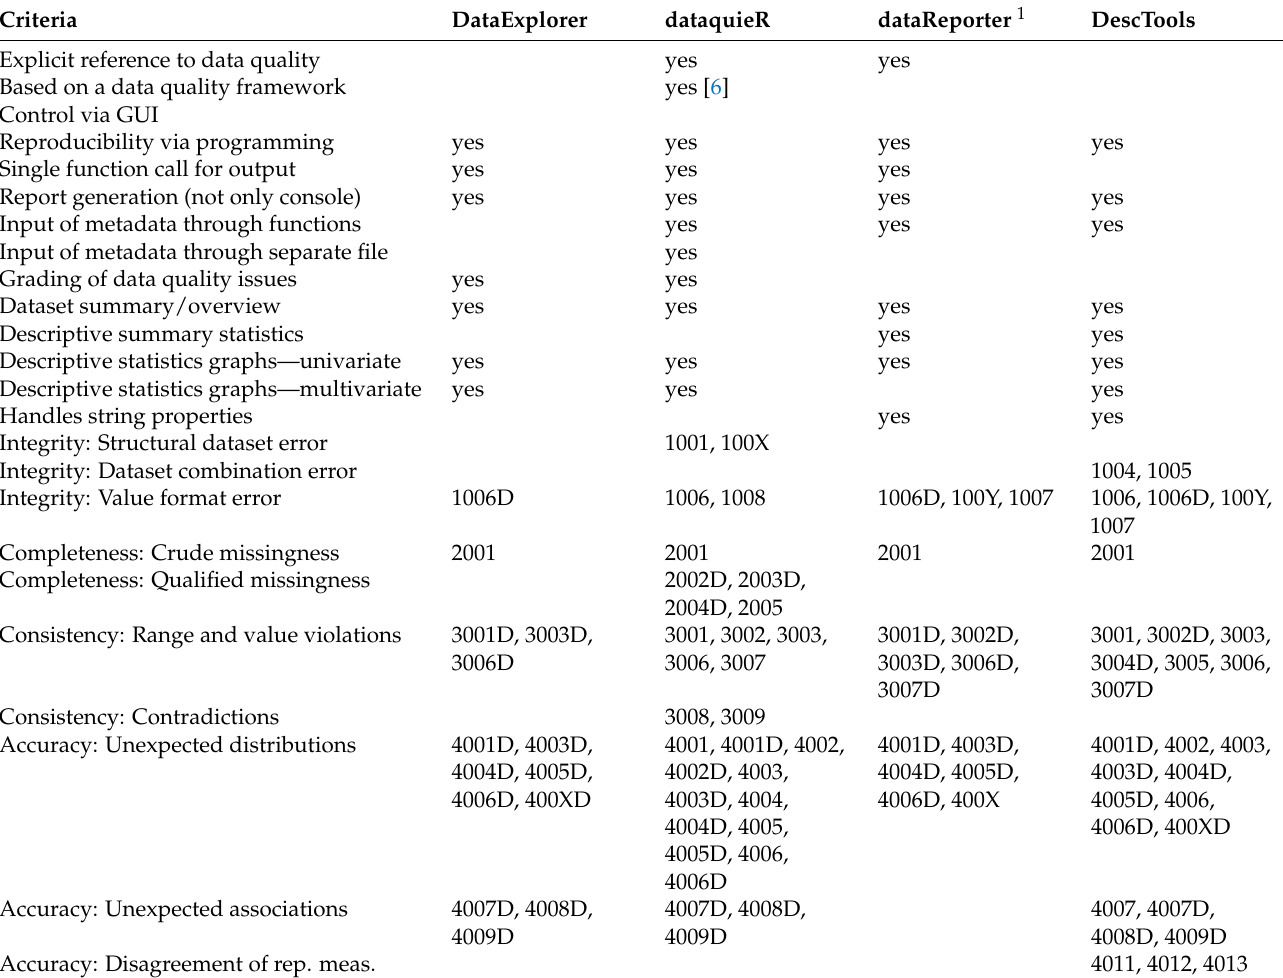
Table A2. Data quality assessment capabilities by package (continued).